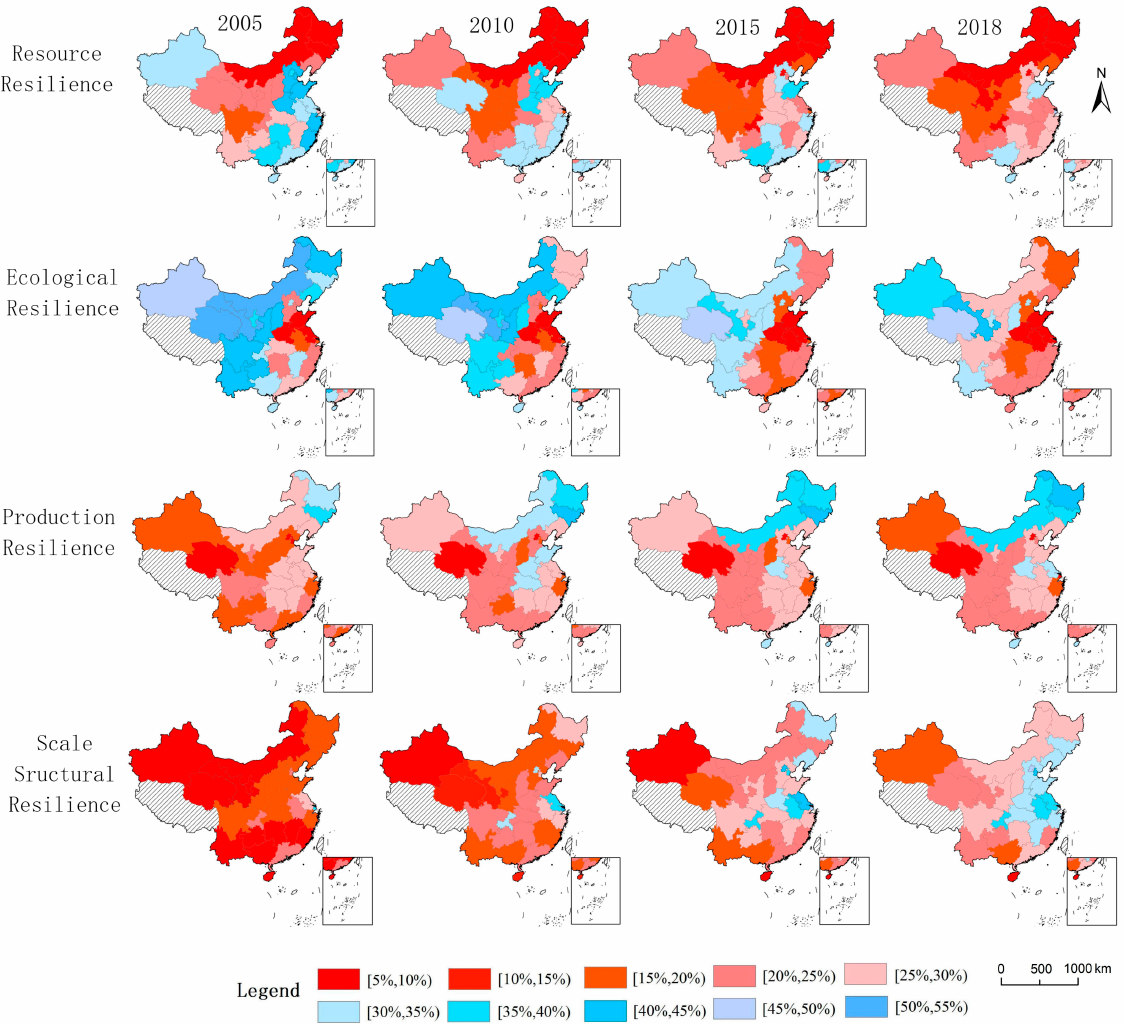
Figure 4. Spatio-temporal pattern of contribution rates of cultivated land use system resilience (CLSR) in some regions of mainland